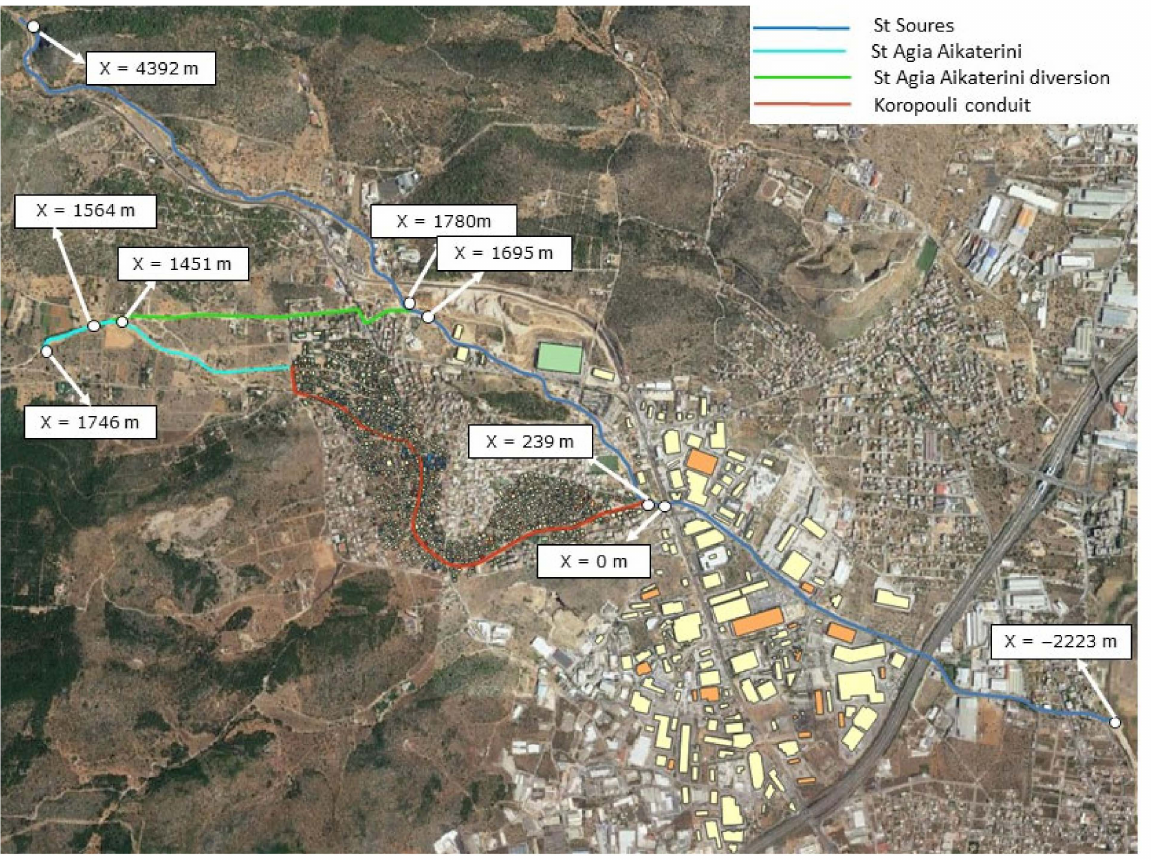
Figure 1. The area of study, the flood protection works, and the areas of